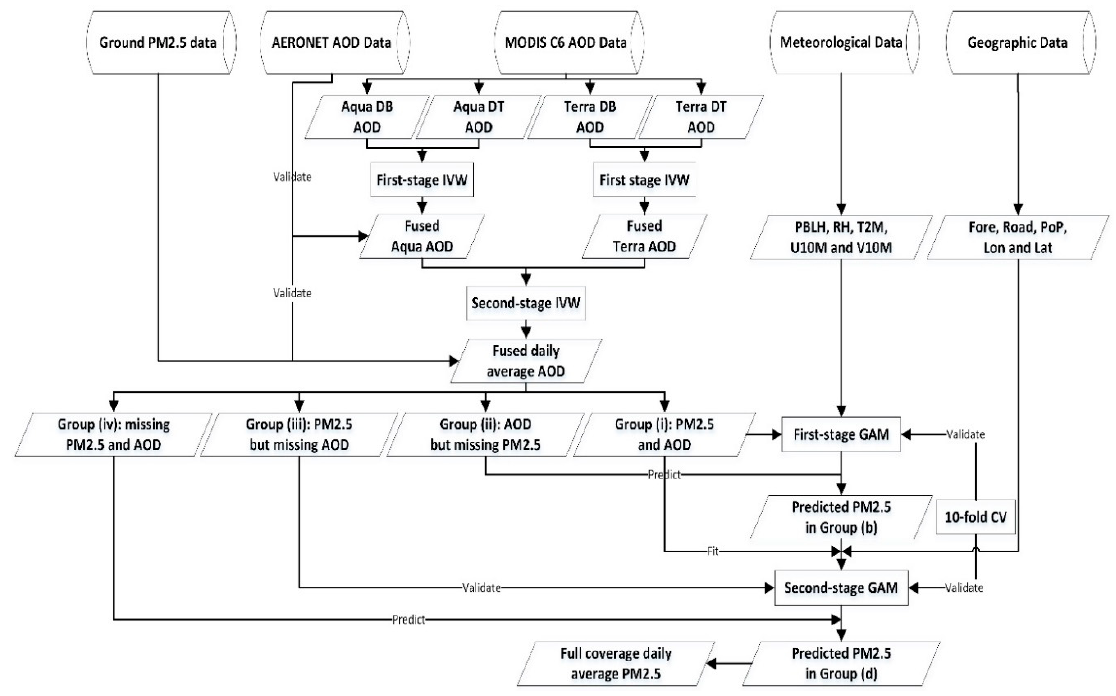
Figure 2. The work flow of our methodology.